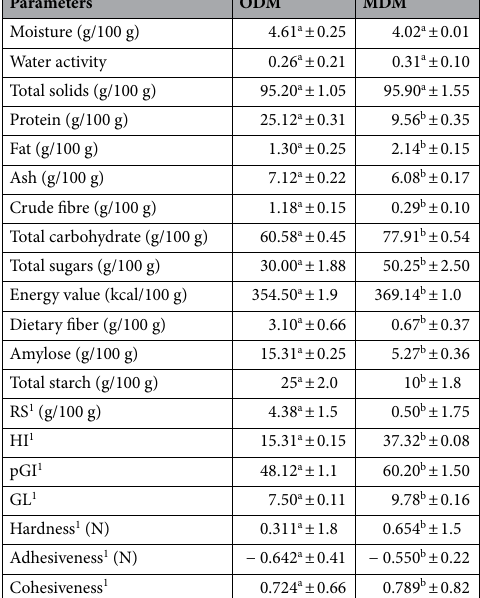
Table 3. Physico-chemical properties of optimized dry mix (ODM)and market dry mix (MDM). 1 Parameters analyzed after reconstitutingODM and MDM. Mean values in rows with different superscripts are significantly different at p ≤ 0.05. RS resistant starch, HI hydrolysis index, pGI predicted glycemic index, GL glycemic